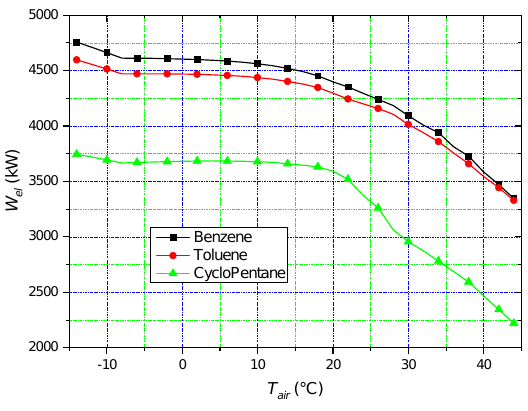
Figure 4. ORC electrical output power varying ambient